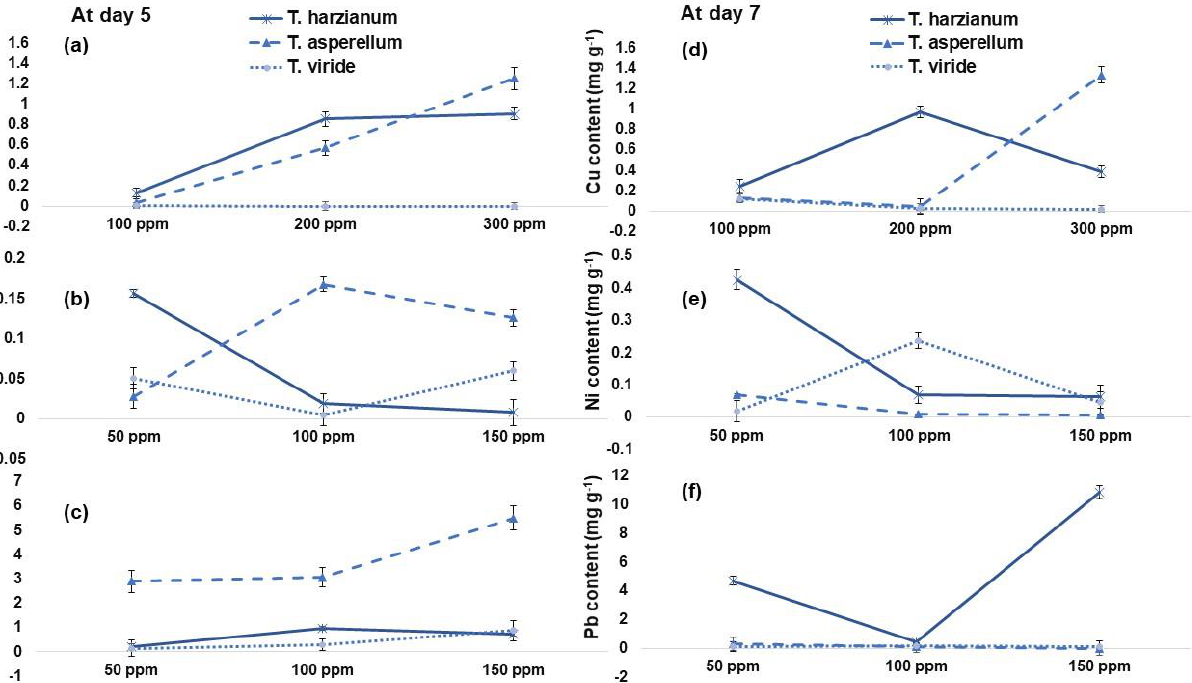
Figure 1. ( a – c ) Total copper (Cu), nickel (Ni) and lead (Pb) content in T richoderma harzianum (F1), Trichoderma asperellum (F2) and Trichoderma viride (F3) at day 5. ( d – f ) Total copper (Cu), nickel (Ni) and lead (Pb) content in Trichoderma harzianum (F1), Trichoderma asperellum (F2) and Trichoderma viride (F3) at day 7, respectively. Values are the average of three replicates.